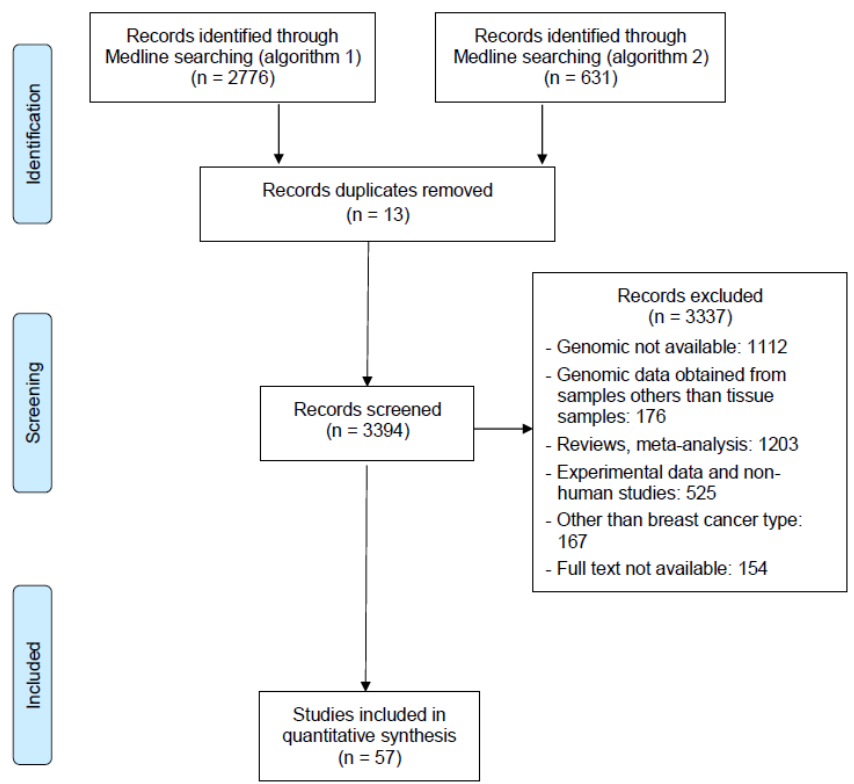
Figure 1. PRISMA flowchart for the screening and selection of the studies.